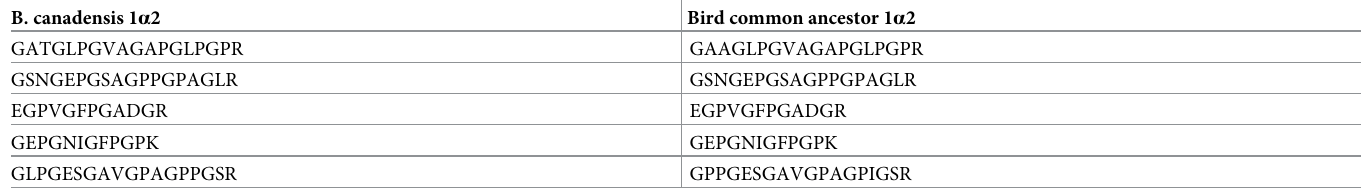
Table 4. Evaluation of reported Brachylophosaurus canadensis collagen 1 α 2 peptides. The corresponding sequences from the constructed common ancestor of birds are in the right column. Amino acid differences are highlighted in yellow. B. canadensis 1 α